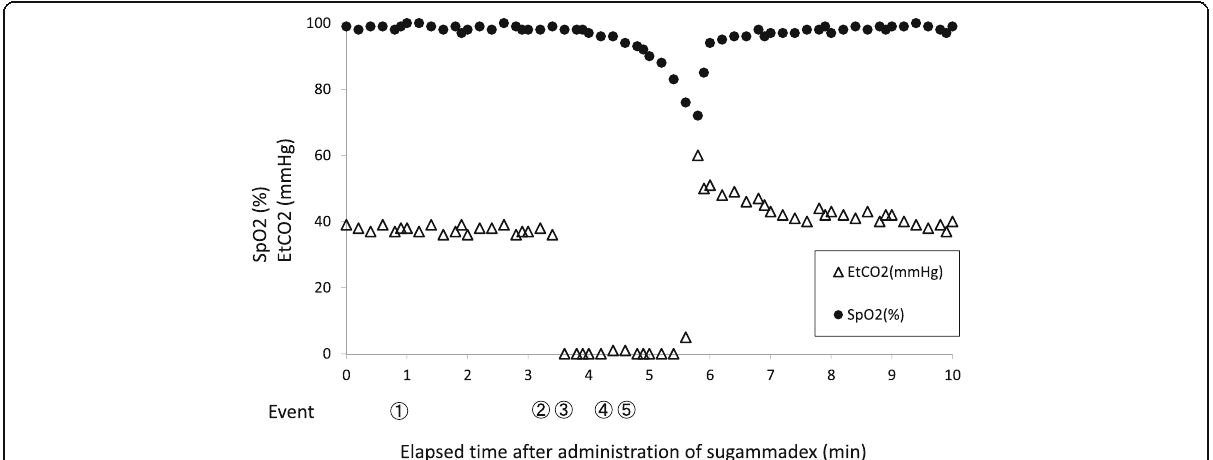
Fig. 1 Changes in end-tidal carbon dioxide and arterial oxygen saturation of pulse oxymetry after sugammadex administration. Event: ① intravenous injection of sugammadex, ② extubation, ③ disappearance of end-tidal carbon dioxide (EtCO2), ④ decline of arterial oxygen saturation, ⑤ start of continuous positive airway